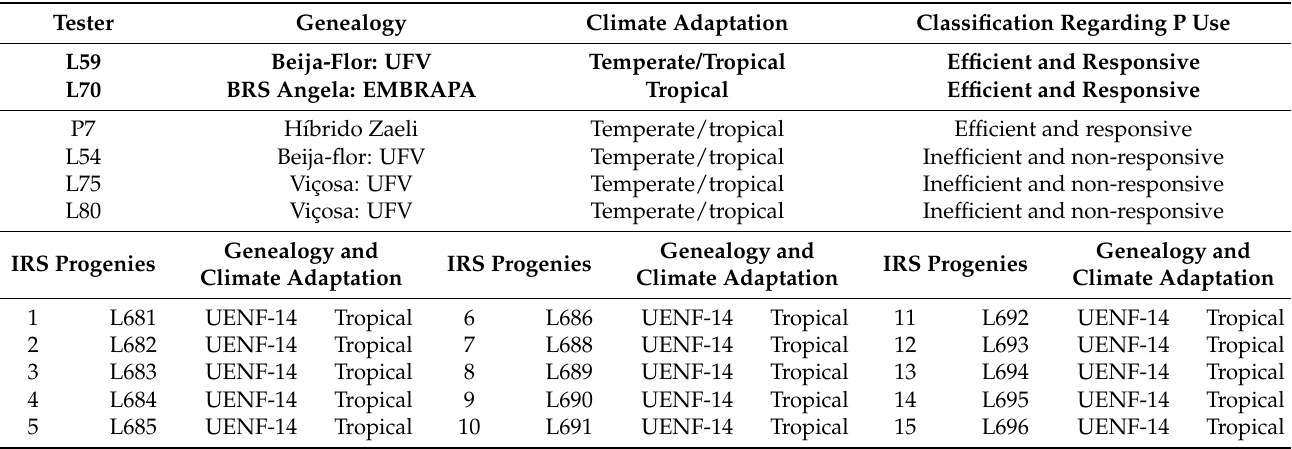
Table 2. Description of the 21 popcorn genotypes from the Active Germplasm Bank of UENF used in the experiments in the North and Northwest regions of Rio de Janeiro State,